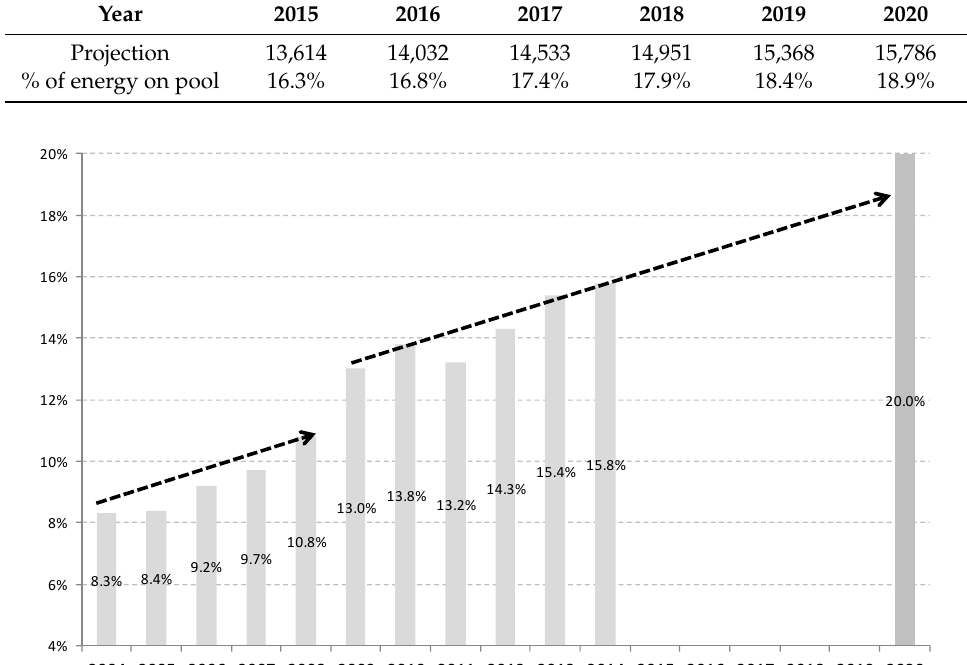
Figure 5. Spain´s renewable energy target 2020 [15,63] (Authors’ calculation from 2015 to